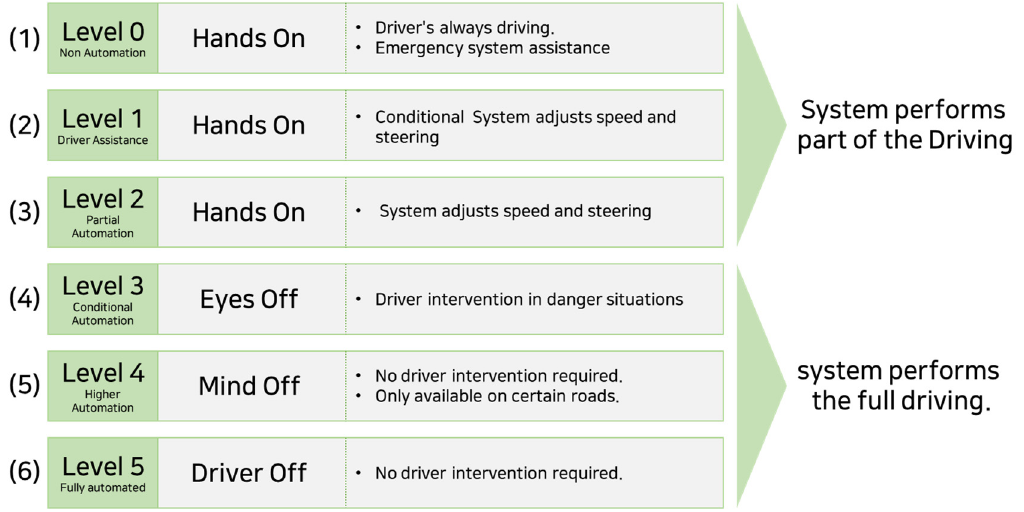
Figure 1. Outline of SAE autonomous levels.